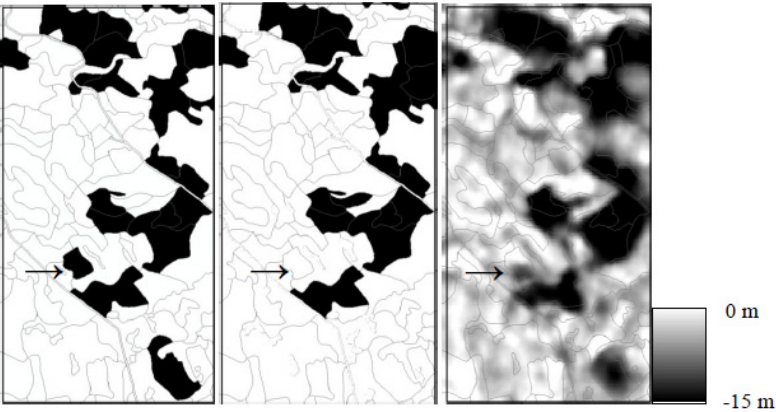
Figure 2. Changes from SRTM-C to Tandem-X over a 1 km × 2 km part of the study area. One stand with partial logging is indicated with an arrow. ( Left ) Clear-cut stands as recorded by the forest owner. ( Middle ) Stands classified as clear-cut based on a mean InSAR DSM decrease < − 9 m. ( Right ) Changes in InSAR DSM in a 10 m × 10 m raster. Only negative changes are shown.